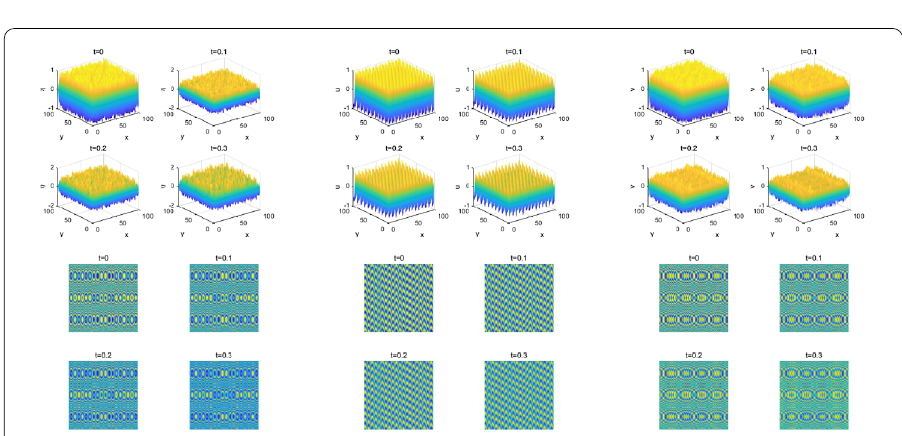
Figure 9 Numerical solution and pattern of Experiment 3, for initial conditions see Table 3